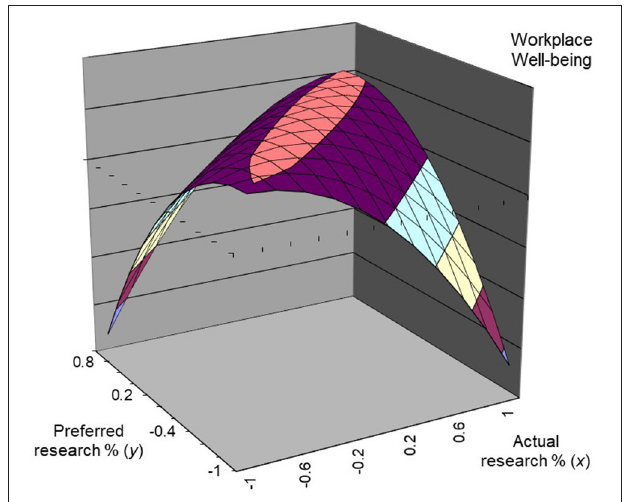
FIGURE 2 | Effects of actual and preferred teaching time allocation on workplace well-being.